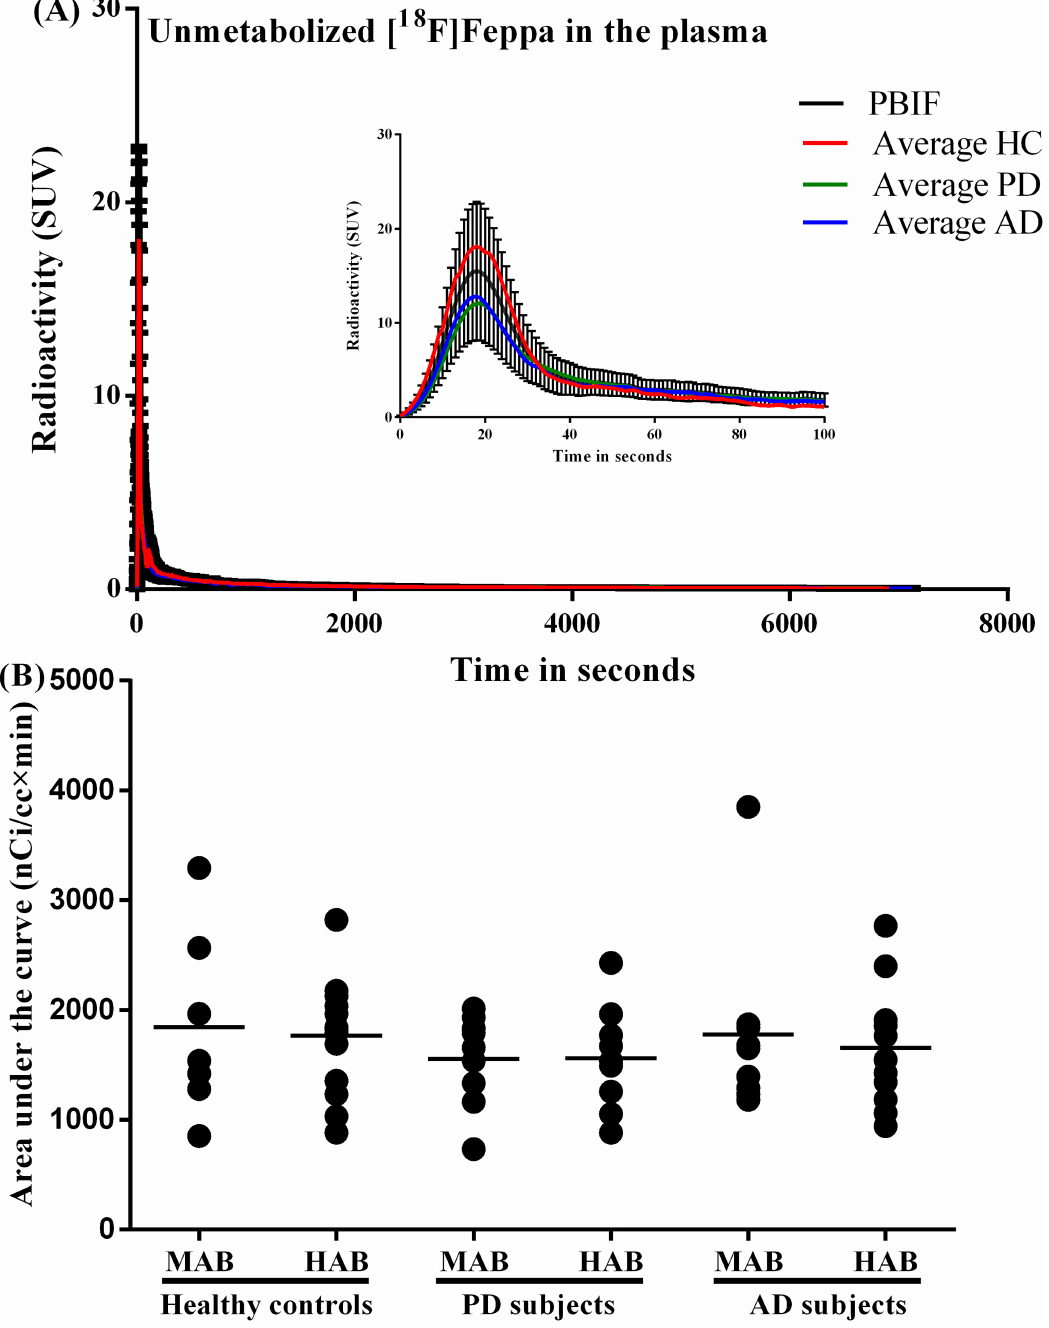
Fig 1. Population based input function. A) Average (n = 24) time evolutionof unmetabolized [ 18 F]FEPPA in plasma from HC (n = 8), PD (n = 8) and AD (n = 8) subjects. The inner plot shows details of the first 100 secondspost injection. B) The area under the curve of the input functions created from arterial blood samplingdid not differ between21 HC, 18 AD and 16 PD.